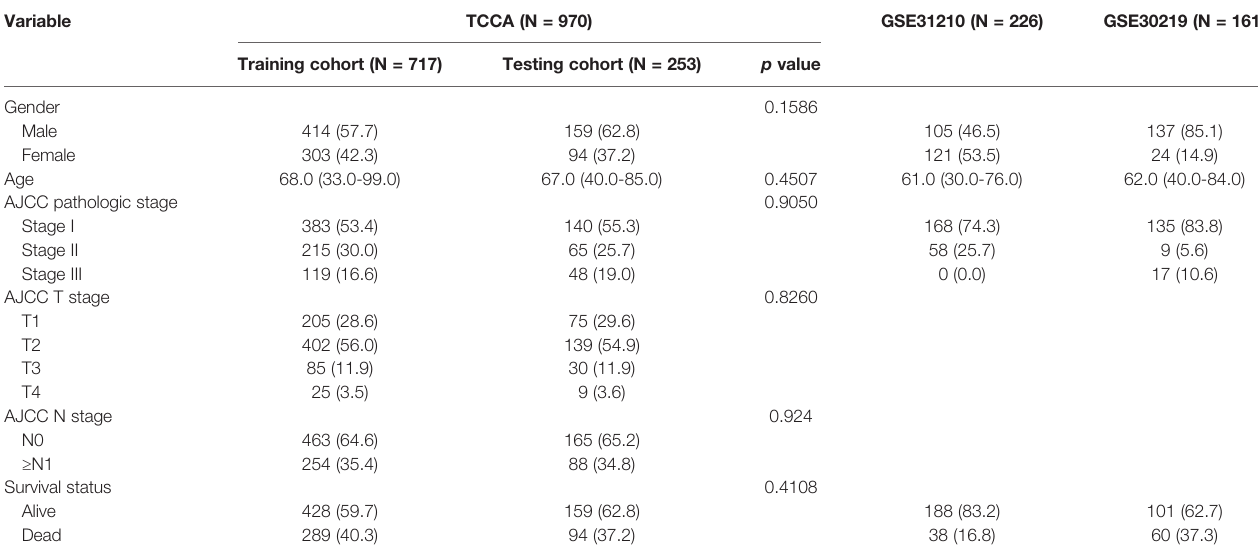
TABLE 1 | Characteristics baseline of patients in